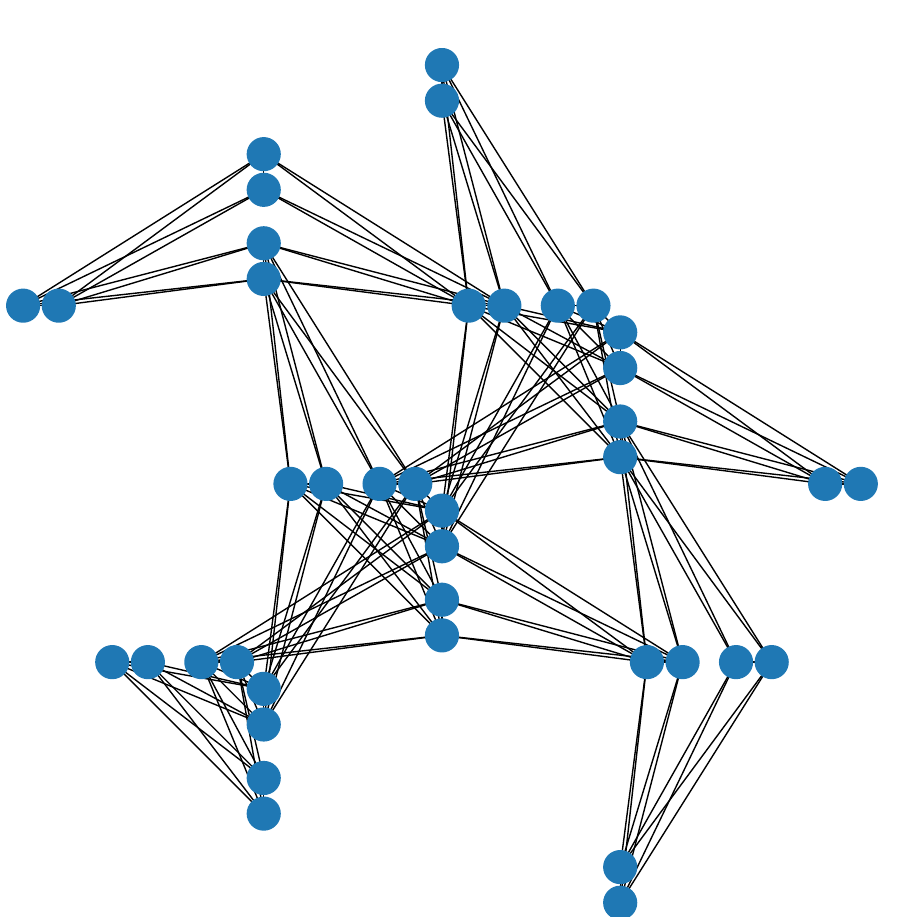
Fig 1. Pegasus graph. The blue circles represent the qubits and the solid black lines represent the connections between the qubits.